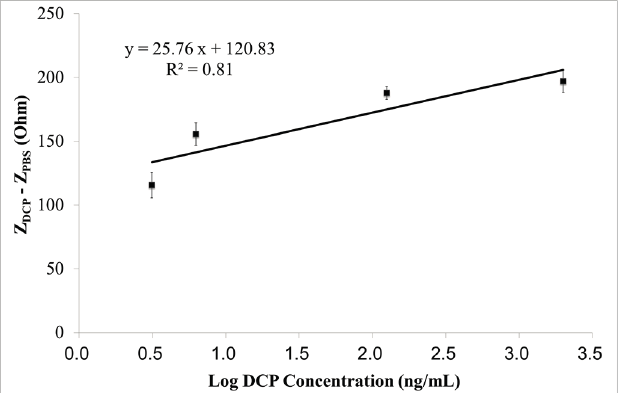
Figure 3. The linear calibration curve (Z DCP − Z PBS vs. Log DCP concentration) of the immunosensor on measuring DCP (3.125–2000 ng/mL) at the optimum measuring frequency of 5 MHz, within the specific frequency range (4.189–5 MHz). Results are expressed in mean ± SD (n = 5).